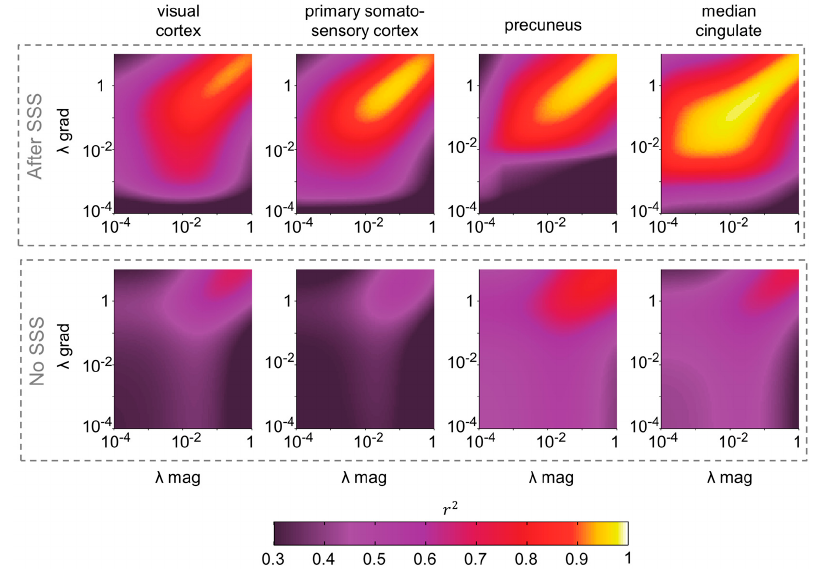
Figure 1. Correlation between source time series derived from magnetometers and gradiometers with and without SSS. Squared Pearson correlation coefficients averaged across subjects are shown for four selected sources as a function of the regularization parameters λ for magnetometer ( x -axis) and gradiometer ( y -axis) beamforming reconstructions. The selected sources were located in MNI space: visual cortex (MNI: [ − 41, − 77, 3] mm), primary somatosensory cortex (MNI: [ − 38, − 27, 52] mm), precuneus (MNI: [1, − 57, 28] mm) and median cingulate (MNI: [ − 2, 12, 40] mm).